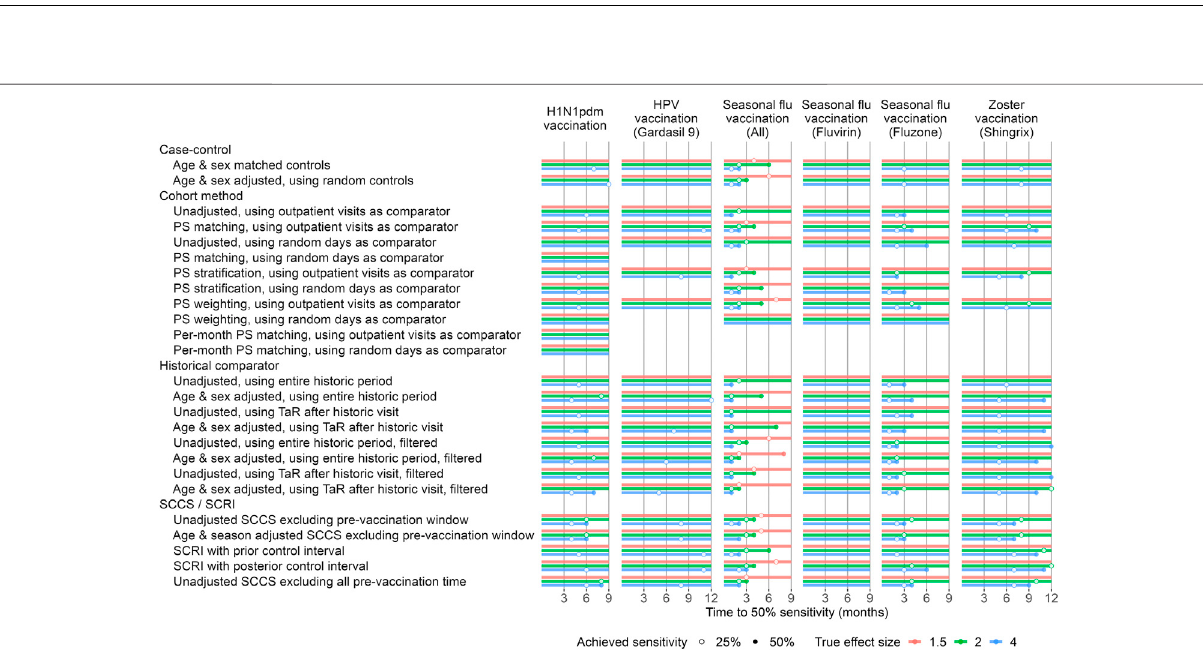
Frontiers in Pharmacology |